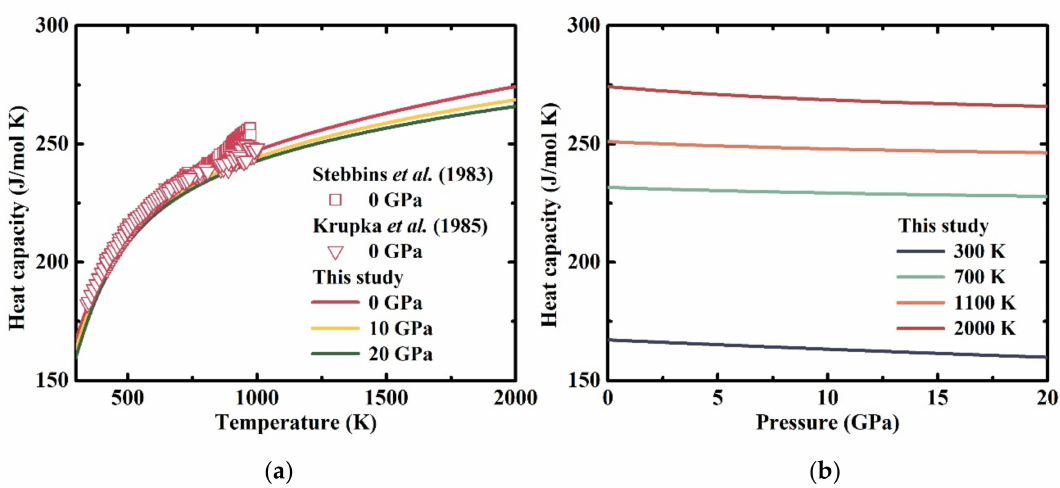
Figure 5. Temperature ( a ) and pressure ( b ) dependences of the heat capacity of diopside. Solid lines refer to our calculated results. The squares and triangles correspond to the results from Stebbins et al. (1983) [32] and Krupka et al. (1985) [30], respectively.